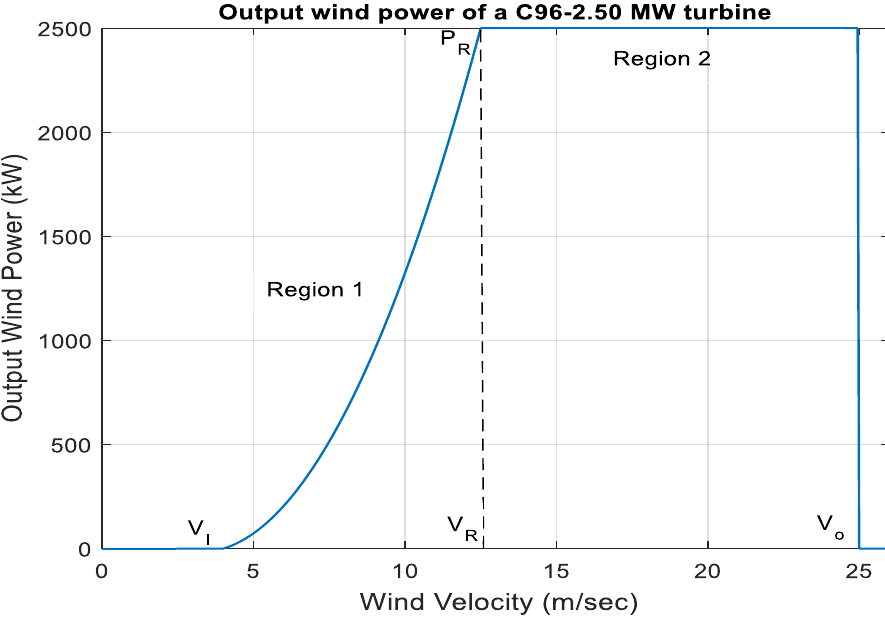
Figure 5. Output wind power of a C96–2.50 MW wind turbine.